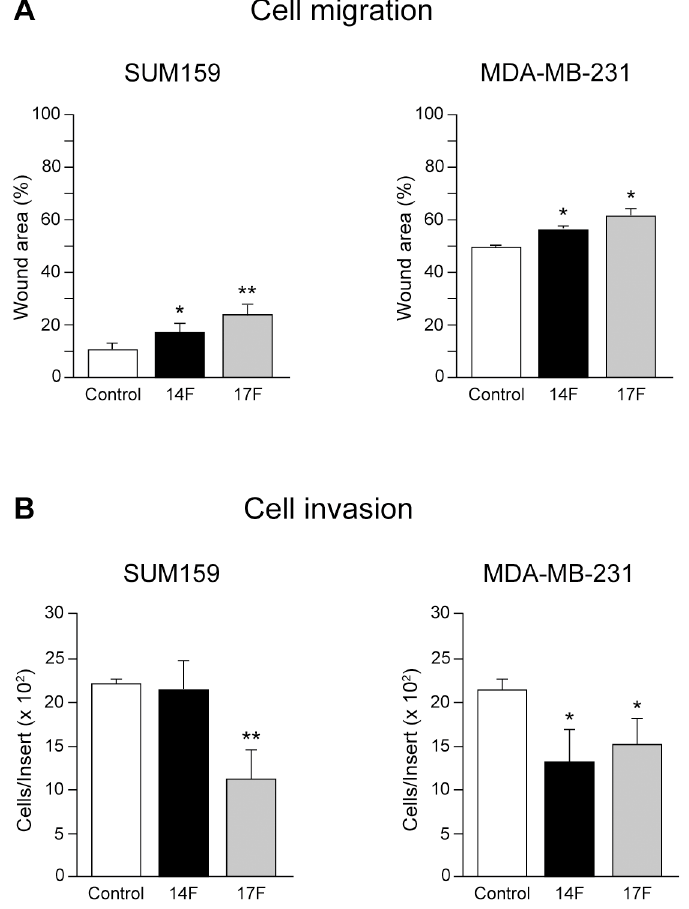
Figure 6. Role of SH2-c-Src directed aptamers in SUM159 and MDA-MB-231 cells to evaluate cellular migration and invasion. Wild type SUM159 and MDA-MB-231 cells were transfected with either control, 14F or 17F aptamers at 100 nM and cell migration ( A ) and invasion ( B ) were determined as described in Materials and Methods. Each experiment was measured in triplicates ( n = 3) and repeated three times. Results were expressed as a percentage of the mean ± SD, * p < 0.5, ** p < 0.01.